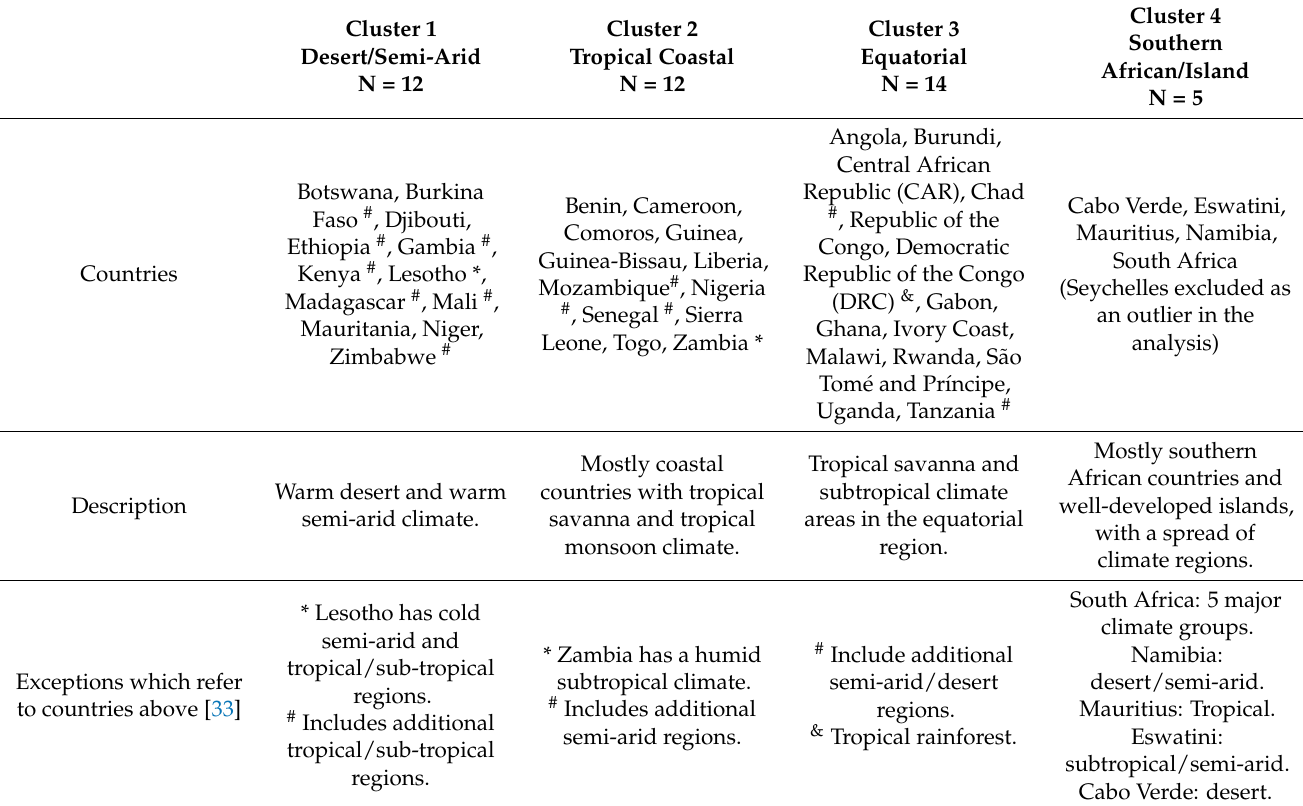
Table 3. Description of the four clusters of SSA